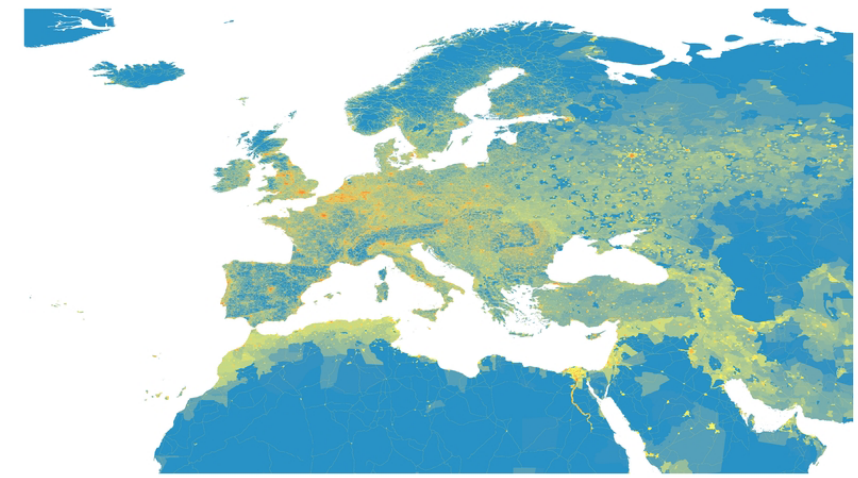
Figure 6. Map of the unitless value calculated for the traffic emission proxy: low (blue) to high (red)